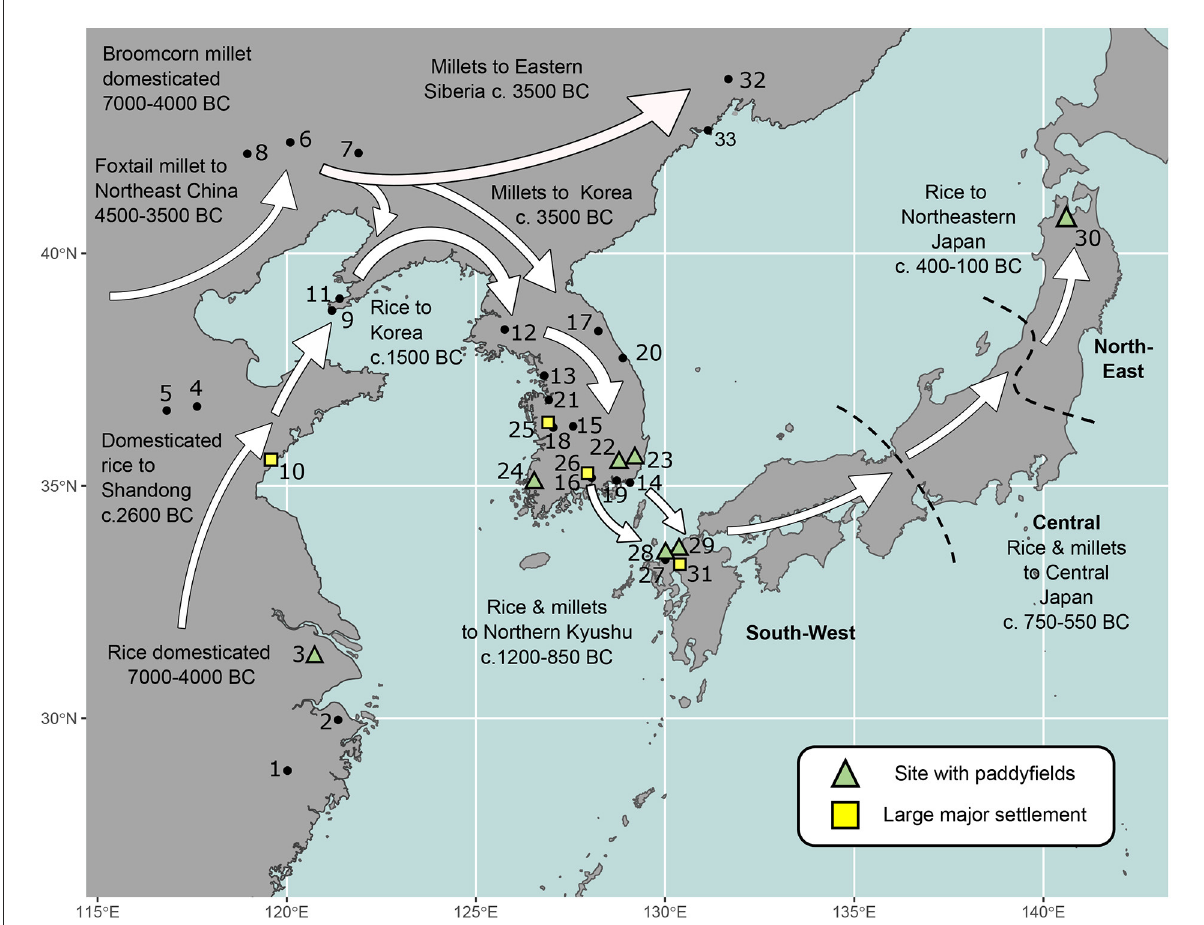
FIGURE2 Major sites for tracking rice and millet dispersal in East Asia. China (early rice sites): 1. Huxi; 2. Hemudu; 3. Caoxieshan; 4. Xihe; 5. Yuezhuang. China (early millets): 6. Xinglonggou; 7. Jiajiagou/Tachiyingzi; 8. Weijiawopu. China (spread of millet / rice): 9. Wangjiacun; 10. Liangchenzhen; 11. Wenjiadun. Korea (spread of millets): 12. Jitap-Ri; 13. Neunggok; 14. Tongsamdong; 15. Daecheon-ri; 16. Pyeonggeodong. Korea (spread of rice): 17. Sacheon-ri; 18. Singari-Sanjik-ri; 19. Oun-1; 20. Gyodong, Gangreung; 21. Daeheung-ri Keuseonjiang, 22. Geumcheon-ri; 23. Okhyeon and Gulhwa; 24. Shinchangdong. Korea (major settlements): 25. Songguk-ri; 26. Daepyeong. Japan (spread of agriculture Karatsu Plain): 27. Ukikunden shellmound; 28. Nabatake. Japan (Fukuoka Plain): 29. Itazuke. Japan (early “leap-frog” migration): 30. Tareyanagi. Japan (major settlement): 31. Yoshinogari. Russia, Primorye (early millet): 32. Krounovka − 1; 33. Gvozdevo − 4. (after Miyamoto,